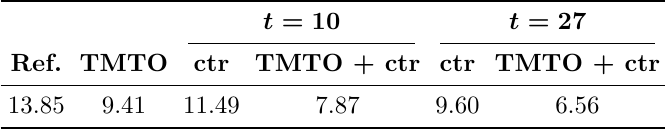
Table 7.3: Benchmarks for signature verification times using the different techniques (see text). Numbers given in million of cycles and are averaged over 100